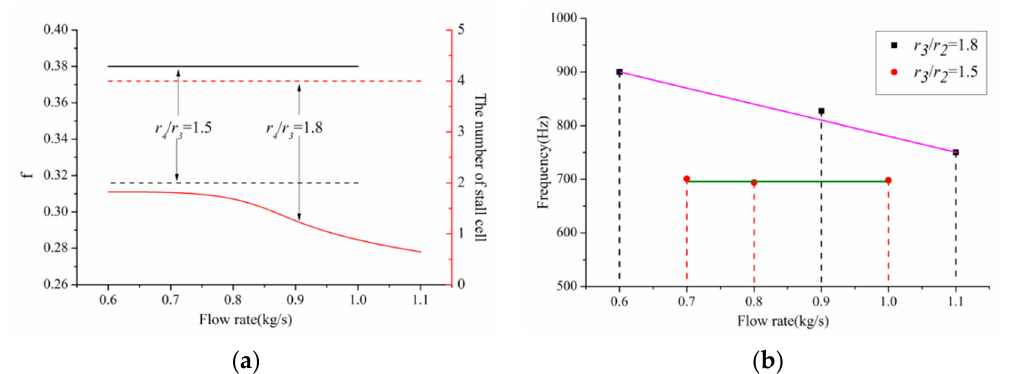
Figure 19. The number of stall cells, the circumferential propagation velocity ratio, and the stall frequency changed with the flow rate: ( a ) the stall cell numbers and the circumferential velocity ratio; ( b ) the stall frequency. ( b ) the stall